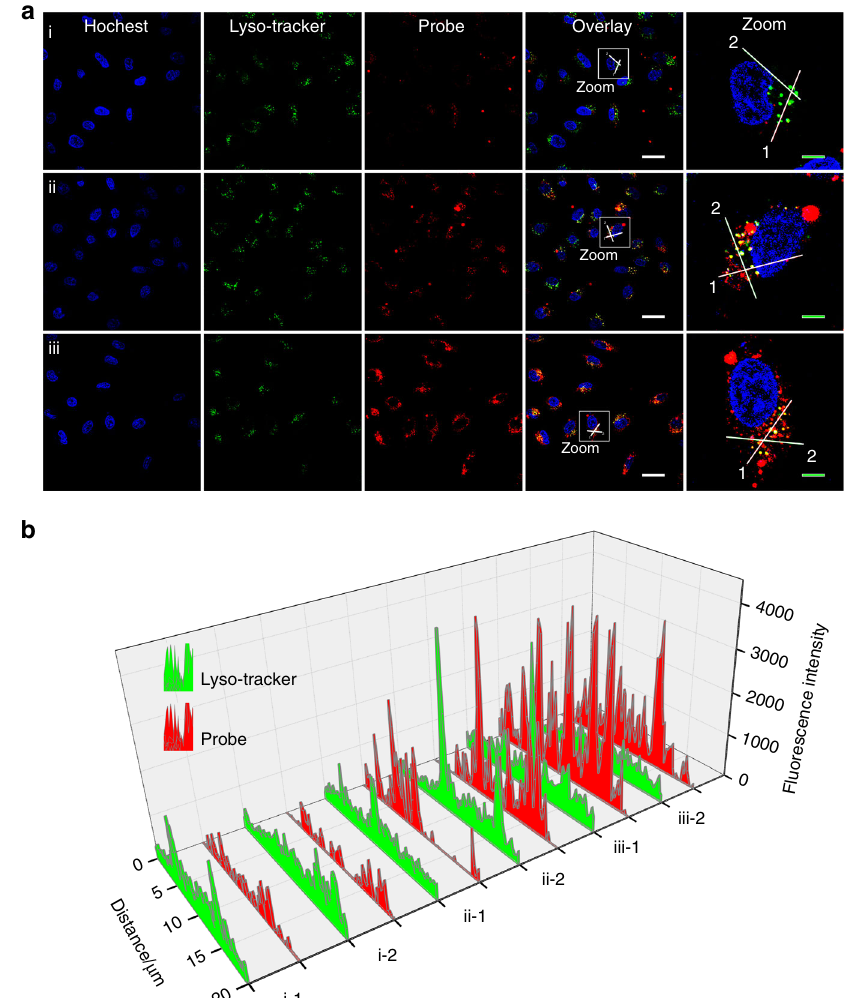
Fig. 3 Time-dependent cellular uptake and intracellular distribution of PCH 2 -Apt-UCNPs. a Confocal laser scanning microscopy (CLSM) imaging of living A549 cells treated with PCH 2 -Apt-UCNPs for 2 h (i), 4 h (ii) and 6 h (iii). b Cy5 fl uorescence intensity analysis of the linear regions (i-1,2 ii-1,2 and iii-1,2) in zoom images. The PCH 2 -Apt-UCNPs was traced with the Cy5 fl uorescence signal. Nuclei and lysosomes were stained with Hoechst 33258 (blue) and LysoTracker Green (green), respectively. Scale bars in overlay images and zoom images represent 30 μ m and 6 μ m,